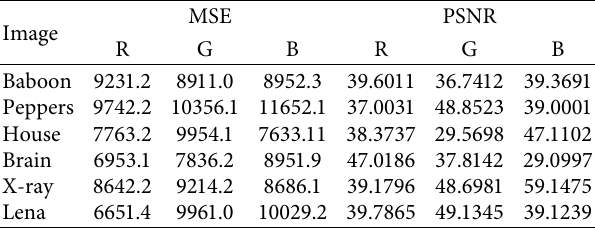
Figure 7: (a–c) Images decrypted from one-bit change key; (d) Image decrypted from the original key. Table 8: MSE and PSNR measures for different standard